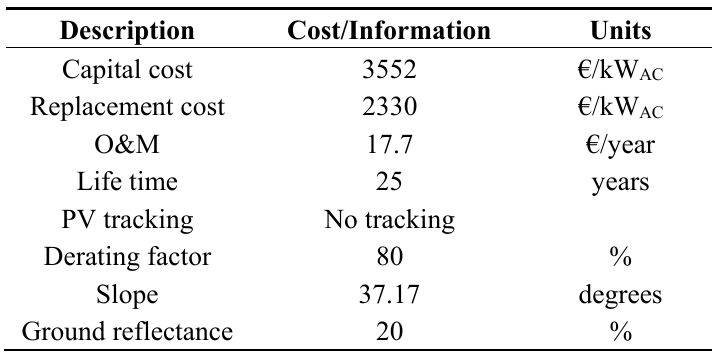
Table 3. PV system cost and characteristics.